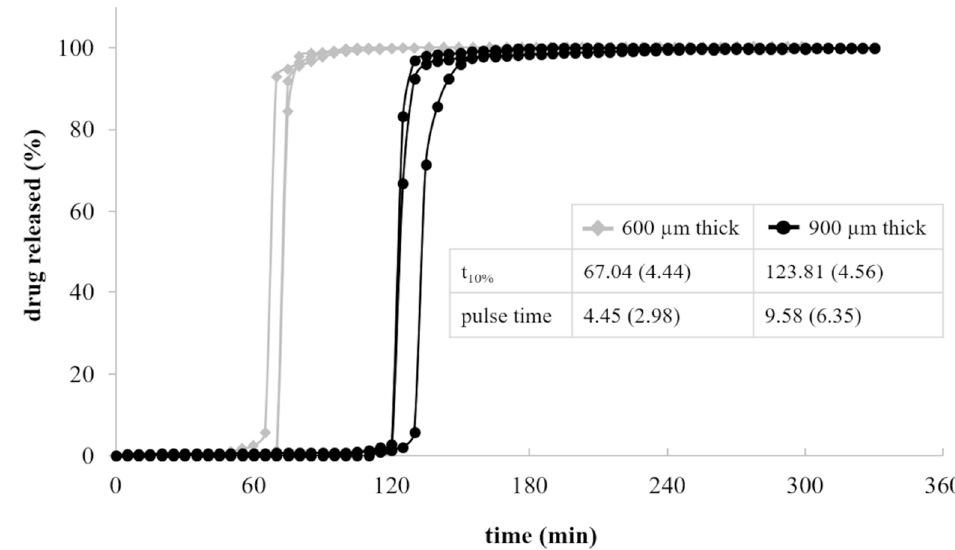
Figure 3. Release profiles of 600 and 900 µm thick HPC-based shells (average release parameters and relevant CV, in brackets, are listed in boxes).